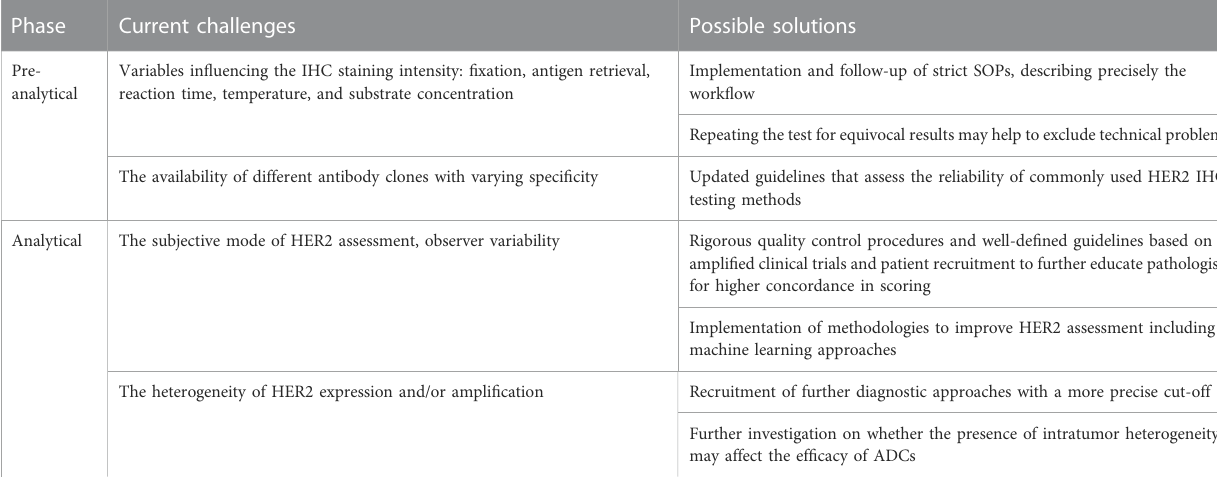
TABLE 2 Summary table listing the current challenges and future directions to improve HER2-low